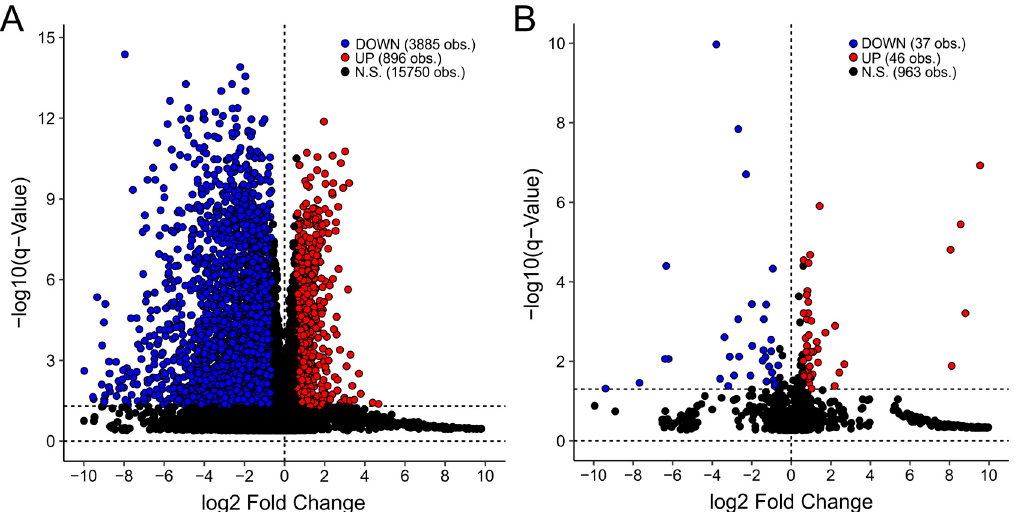
Figure 1. Volcano plots of cellular differentially expressed genes (DEGs) between EBVaGC and EBVnGC samples for the TCGA STAD ( A ) mRNA and ( B ) miRNA datasets. Red dots represent cellular genes that are significantly upregulated in EBVaGCs compared to EBVnGCs. Blue dots represent cellular genes that are significantly down-regulated in EBVaGCs compared to EBVnGCs. Black dots represent cellular genes that are not significantly up- or down-regulated or show less than a 1.5-fold decrease or increase in gene expression in EBVaGCs compared to EBVnGCs. Calculations were performed with an FDR of 5%.